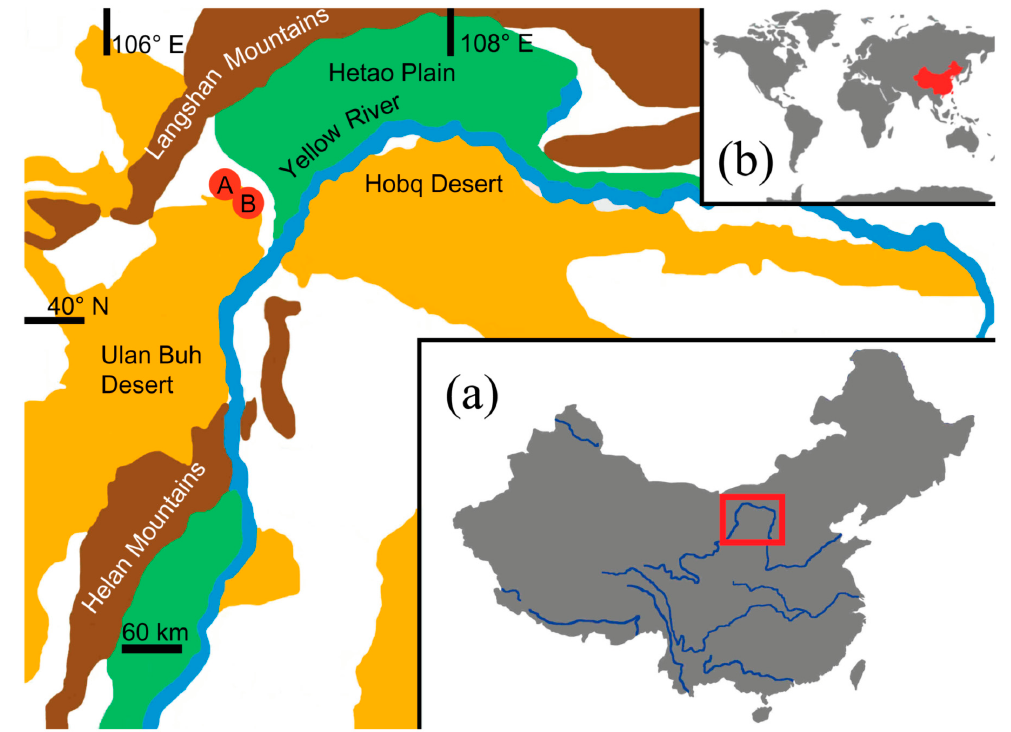
Figure 1. Schematic representation of the study area and location of the two sampling sites, A and B. The inset ( a ) shows the location of the study area in China, and the inset ( b ) the location of China. Insects 2020 , 11 , x FOR PEER REVIEW